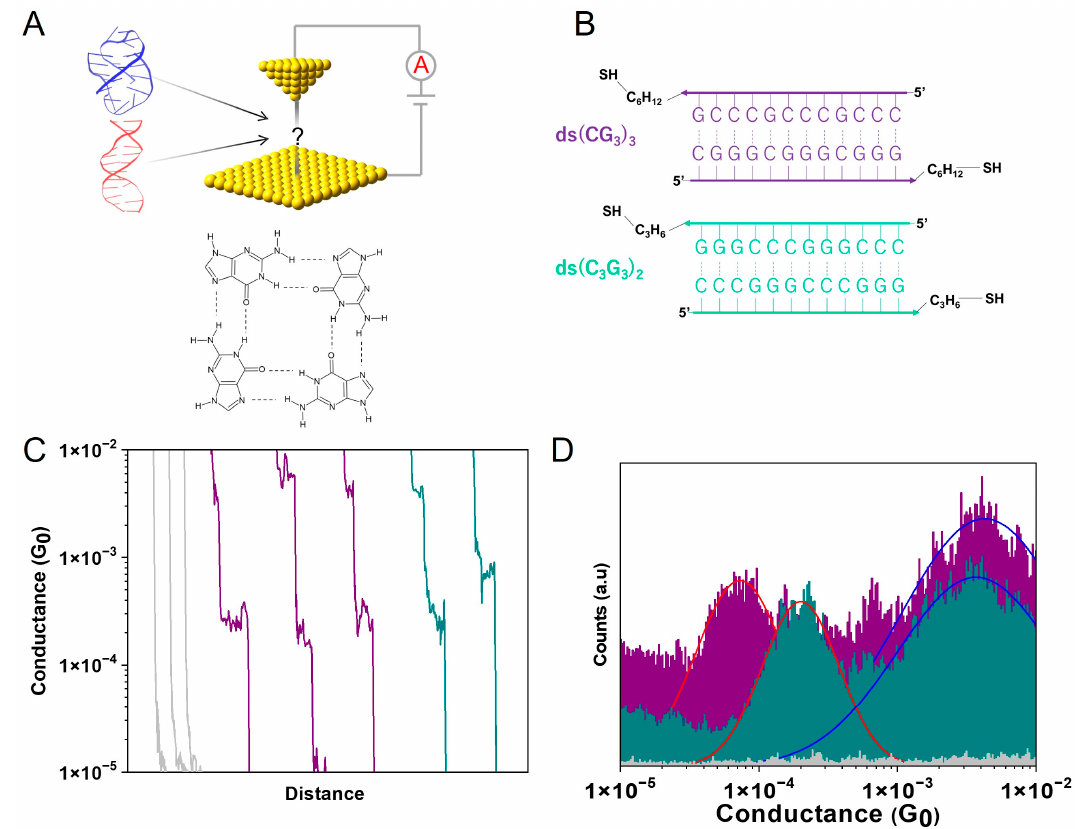
Figure 1. ( A ) Schematic of the SMBJ setup, a planar G-tetrad, and G-quadruplex (blue) and B-form dsDNA (red) structures. ( B ) DNA sequences used in this experiment in their double-stranded configuration, ds(CG 3 ) 3 (purple) and ds(C 3 G 3 ) 2 (dark cyan). ( C ) Multiple single-molecule conductance vs. distance traces at room temperature. The gray traces demonstrate when no molecules bind to the electrodes, and the purple and green are for (CG 3 ) 3 and (C 3 G 3 ) 2 when binding to electrodes, respectively. All traces were offset horizontally for clarity. ( D ) Conductance histograms for (CG 3 ) 3 (purple), (C 3 G 3 ) 2 (dark cyan), which show two conductance peaks each, and the control experiment for blank buffer. The blue and red lines are gaussian fittings to the peaks (see Supplementary File).